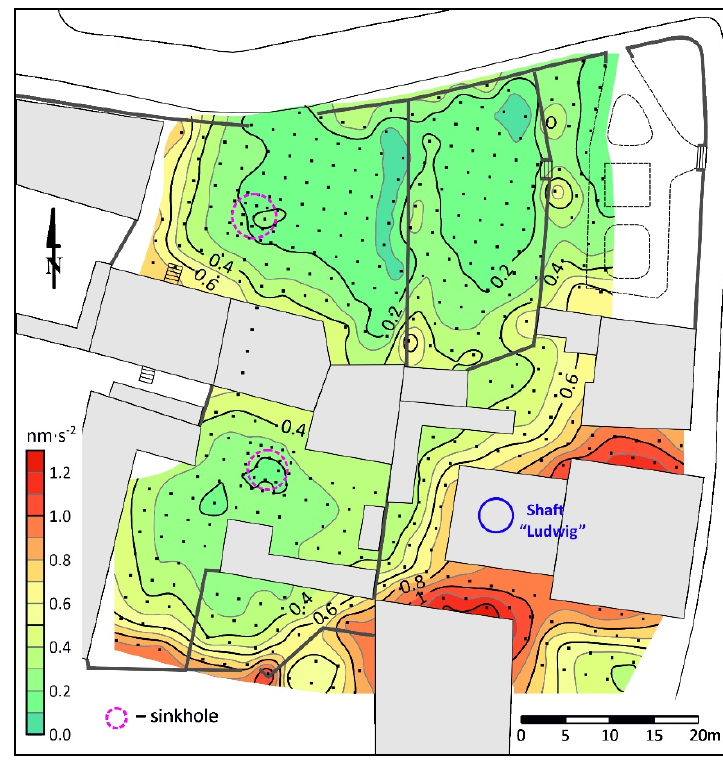
Figure 9. Distribution of a sum of building and terrain corrections.